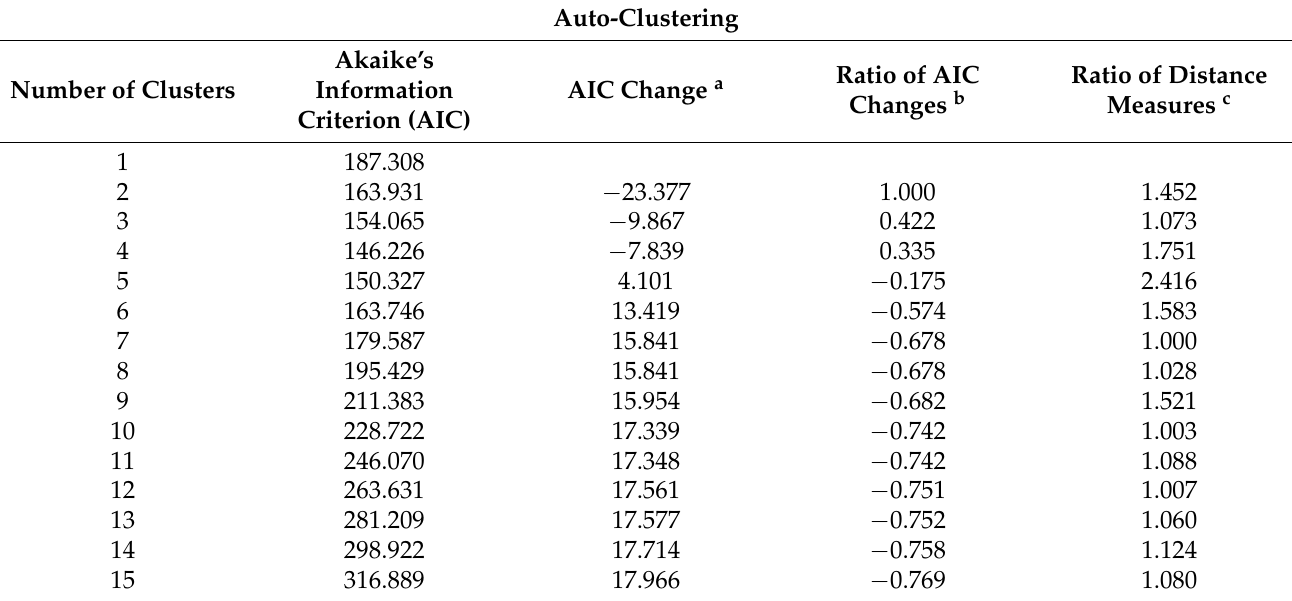
Table 1. Akaike Information Criterion.